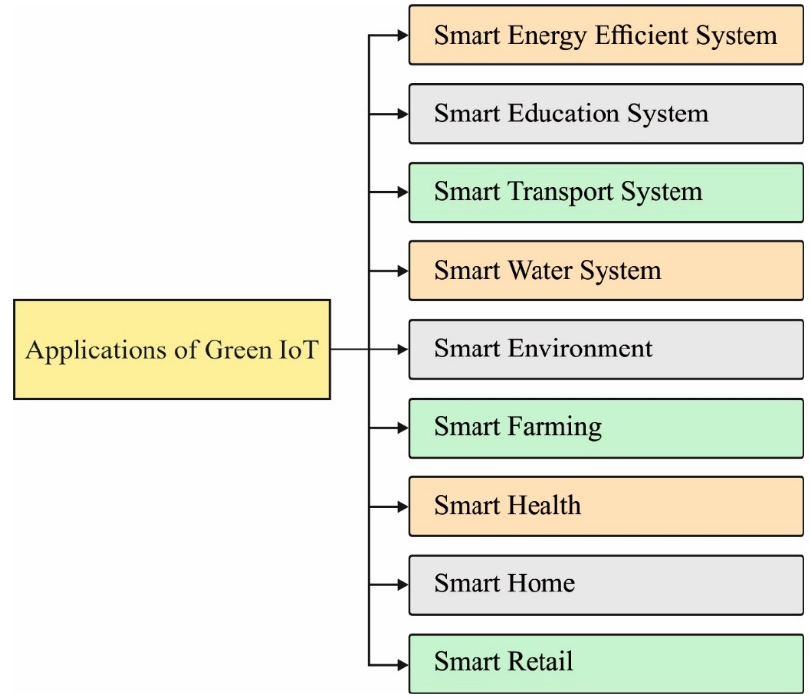
Figure 1. The Application of IoT.